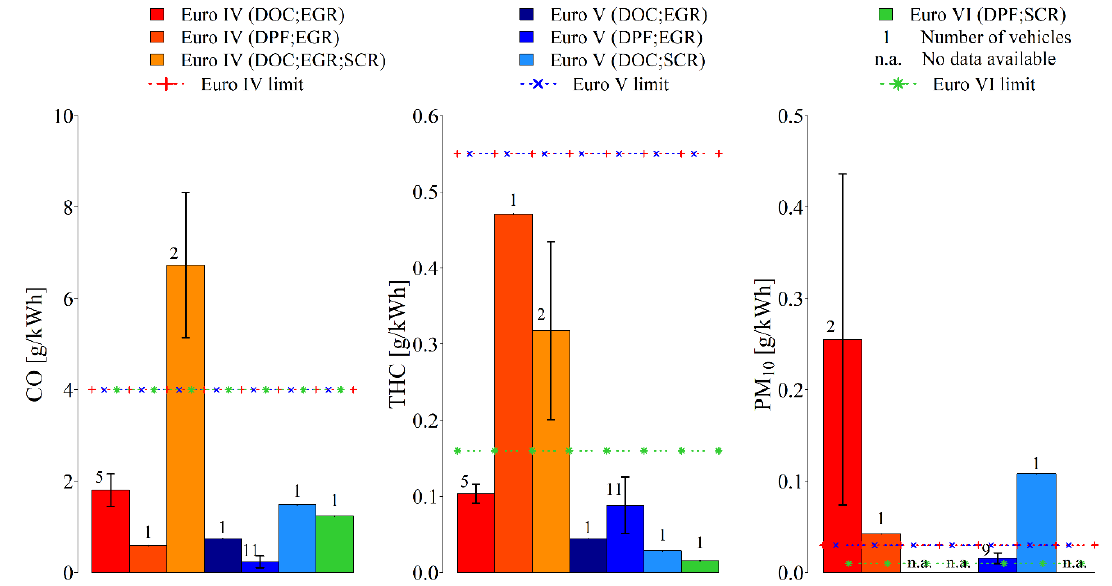
Figure 4. Comparison of the energy-based emission factors (median value of speed-bins) per vehicle class to the respective Euro standard limits. Error bars correspond to ± one standard error limits.